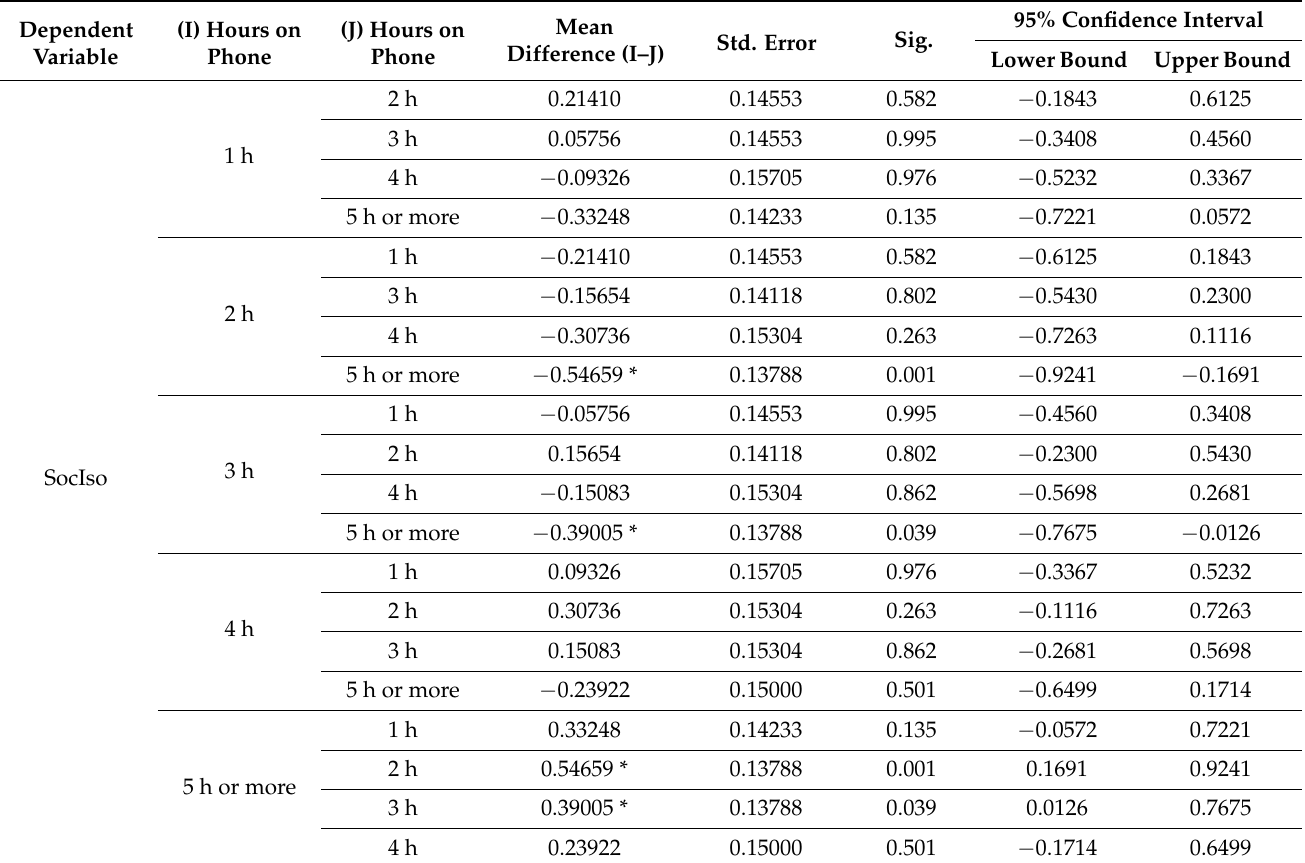
Table 20 provides the statistical significance of the differences between each pair of groups’ hours on the phone. As observed in Table 20, the five groupings were statistically different from one another. Table 20. Multiple comparisons analysis of the SocIso attributed to the number of hours on smart- phones using Tukey